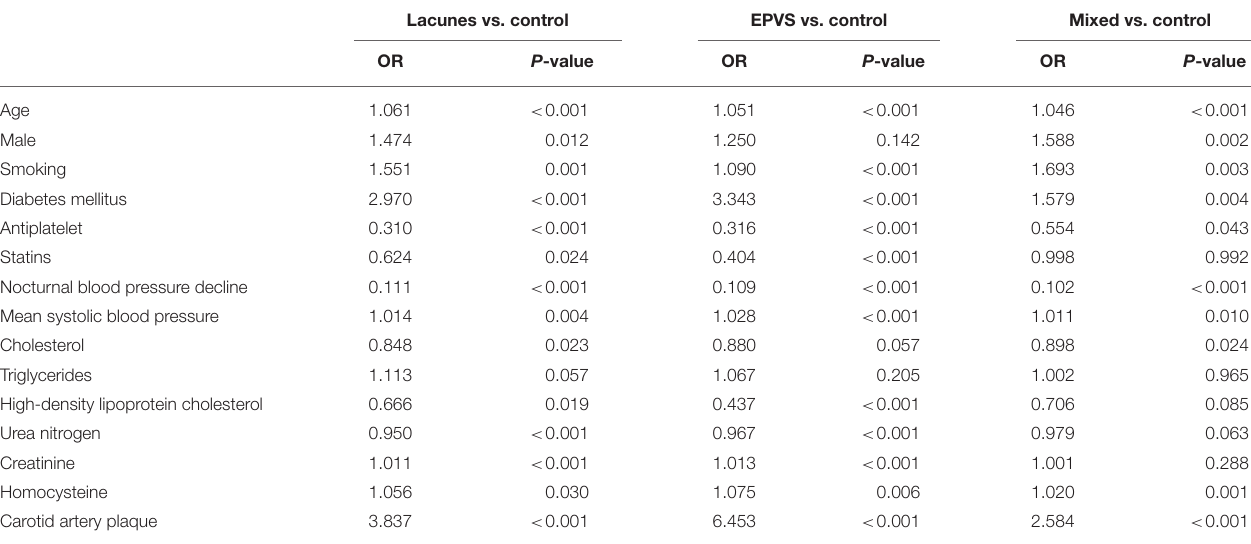
TABLE 2 | Univariate logistic regression analysis between